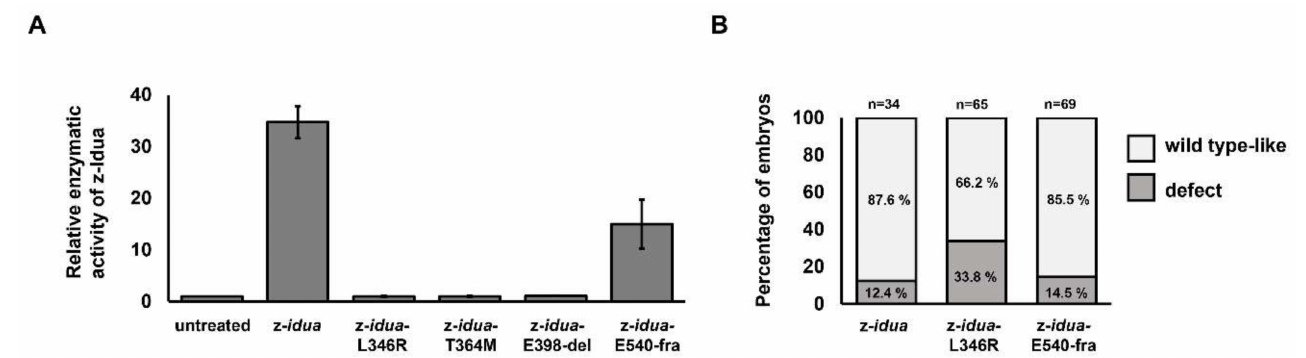
Figure 2. The z-Idua enzymatic activity and occurrence of defective phenotypes in zebrafish embryos was impacted by injection of mutated z- idua mRNA into embryos. ( A ) The z-Idua enzymatic activity of untreated zebrafish embryos at 24 hpf, which served as the control group, was quantified and normalized as 1 for comparison with the relative z-Idua activity obtained from the other experimental groups. The z-Idua enzymatic activity of embryos injected with 100-pg zebrafish idua mRNA (z- idua ; served as positive control) and various point-mutated z- idua mRNAs, as indicated, were quantified. Each point-mutation that occurred in z- idua corresponded with that of human MPS I patients. ( B ) Embryonic phenotypes were examined at the 120 hpf zebrafish embryos injected at one-cell stage with 100-pg zebrafish idua mRNAs (z- idua ), including mutated variants, as indicated. Each mutated zebrafish idua